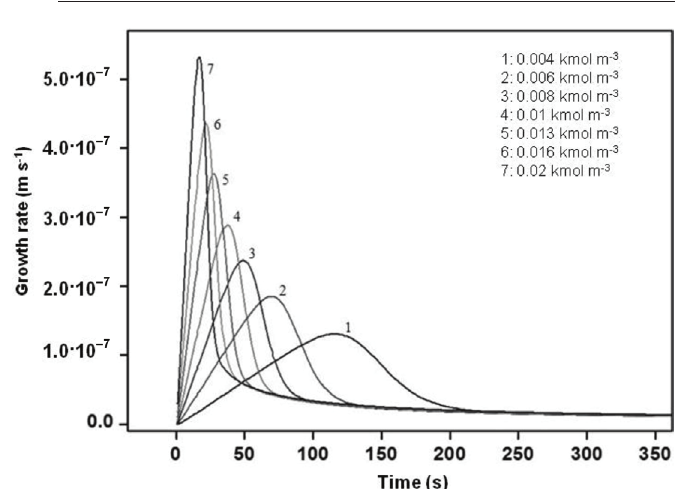
Fig. 4 – Effect of concentration on growth rate during pro- cess of semi-batch reactive crystallization of calcium oxalate at 5 mL min –1 feed rate